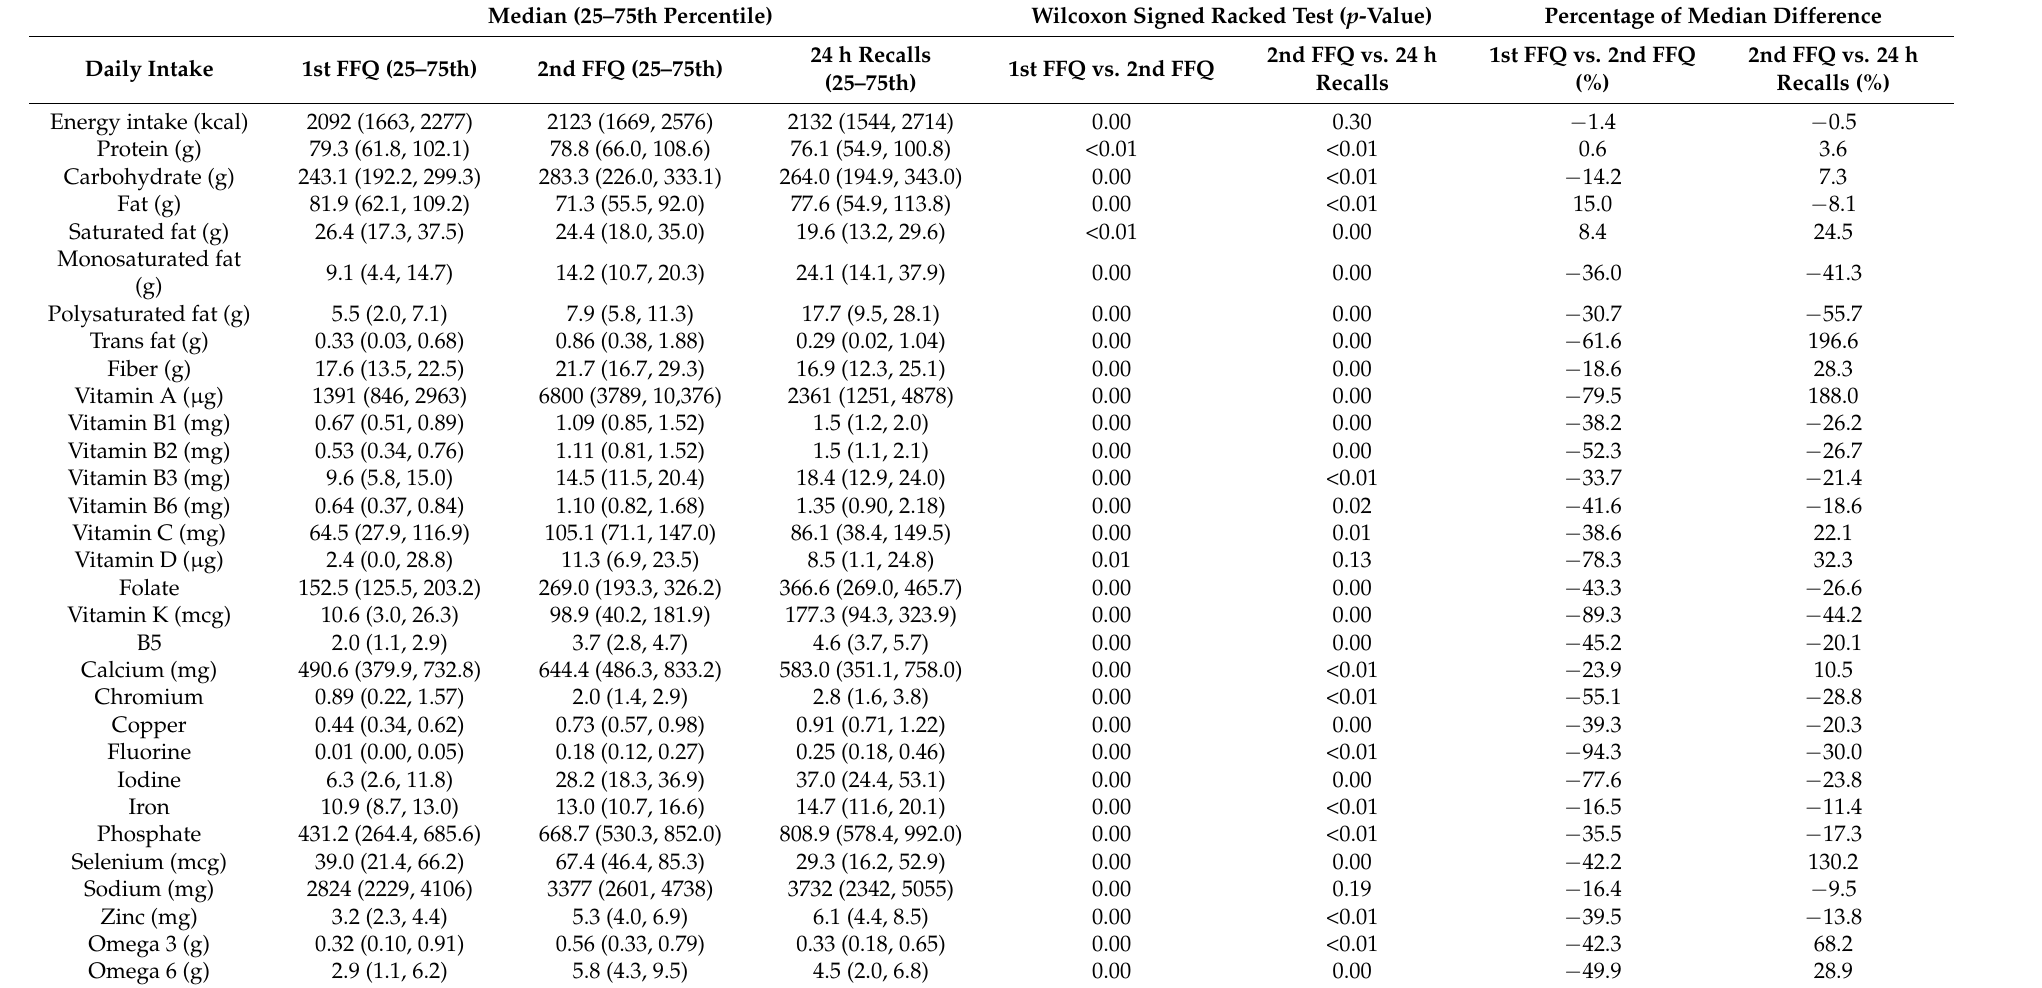
Table 1. Median comparison of nutrients intake between two FFQ surveys and average of the 24hDR recalls among